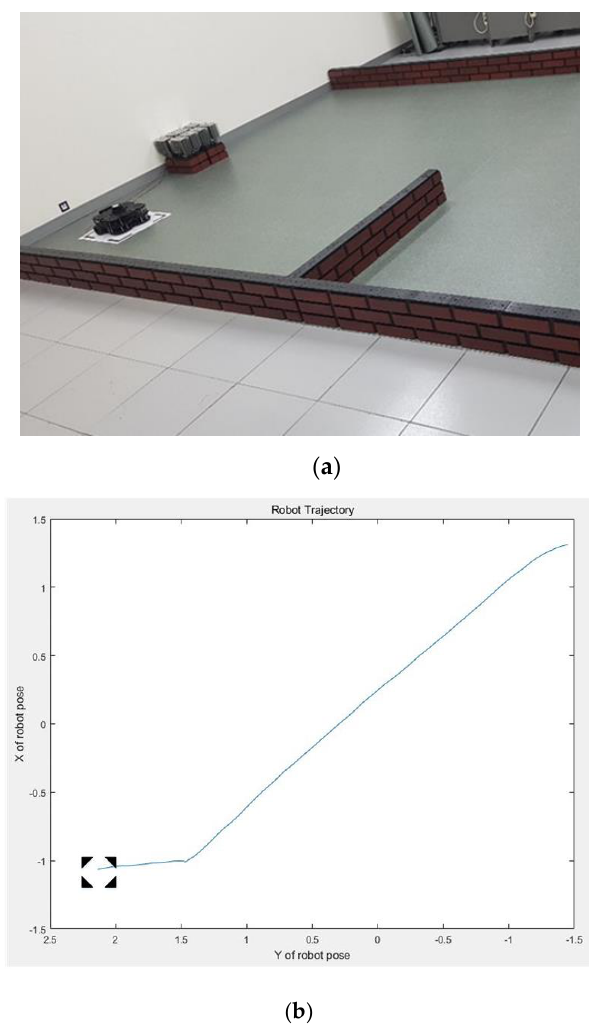
Figure 12. Docking with the charging coil. ( a ) Robot on charging pad; ( b ) Robot trajectory.